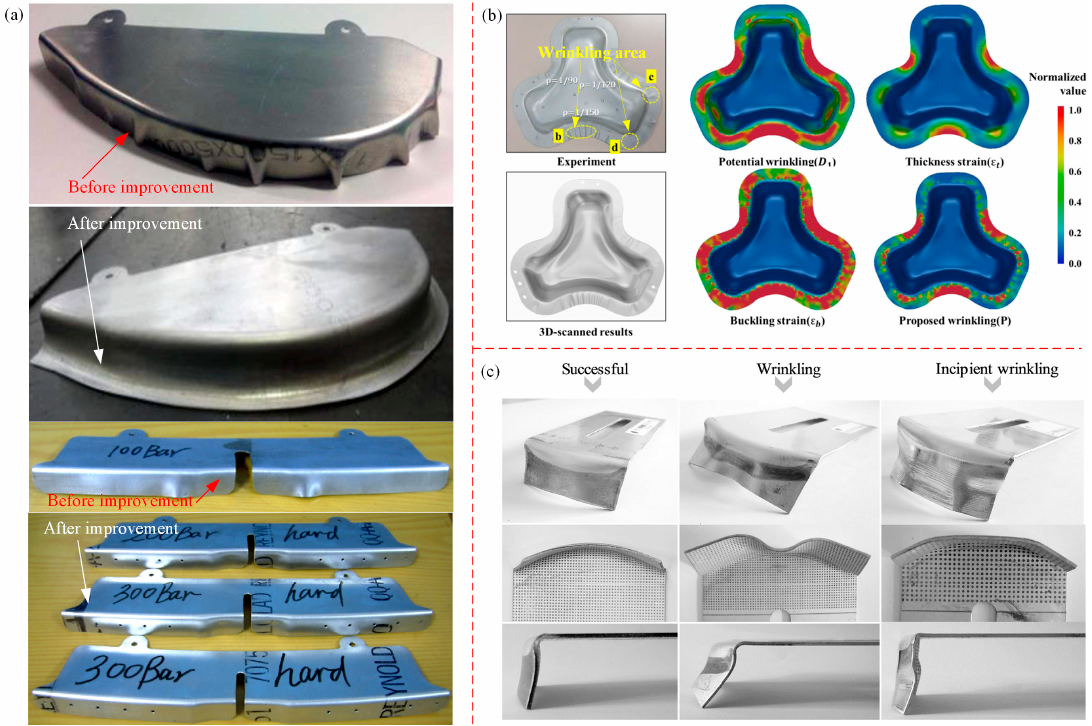
Figure 10. Wrinkling behavior of sheet metal stamping: ( a ) sheet metal stamping of a high curvature large flange [121,122]; ( b ) wrinkling of GPa-grade steel, comparison analysis of representative wrinkle area (wrinkling area b, c and d) with the simulation results [123]; ( c ) failure mode of a AA2024-T3 thin plate [124].